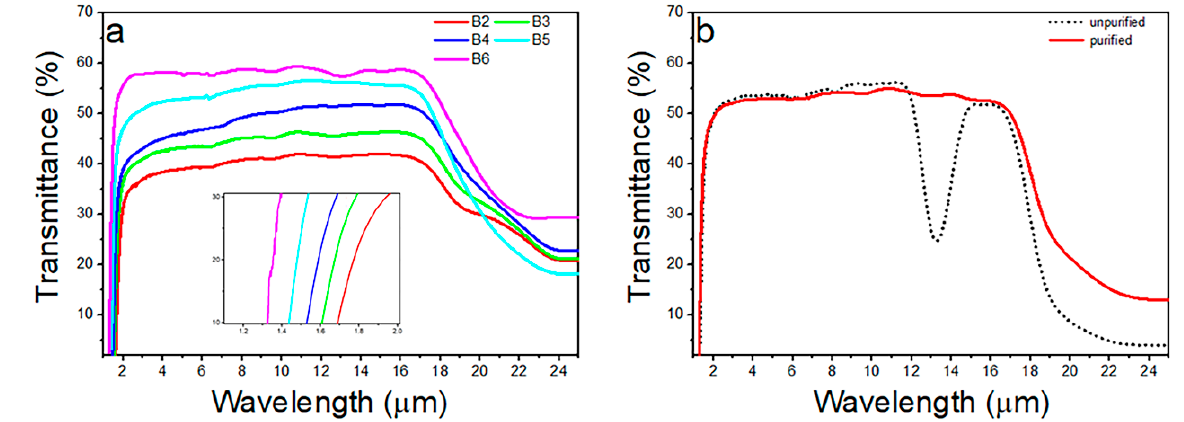
Figure 5. ( a ) Transmission spectra of B2–B6: Se 10 (Ge 0.1 As 0.9- x Te x ) 90 ( x =0.7-0.3) glasses (inset is enlarge of the short-wave cut-off edge) and ( b ) transmission spectra of B11: Se 10 (Ge 0.2 As 0.5 Te 0.3 ) 90 glass before and after purification.